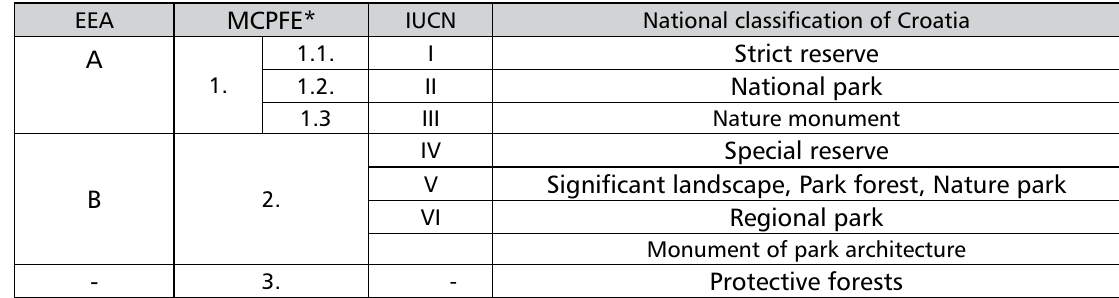
Analogies between different classification systems of protected and protective forests (modified on the basis of